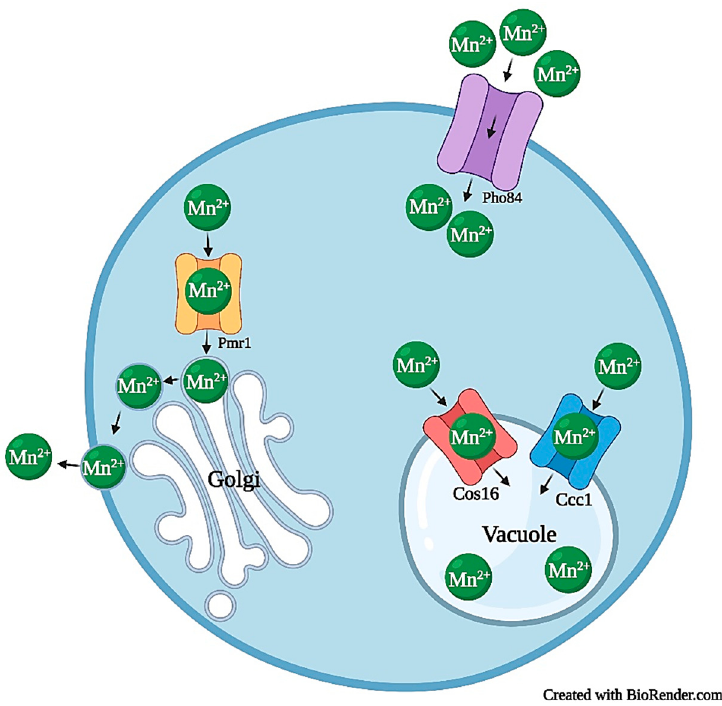
Figure 3. Mn 2+ uptake and detoxification systems in S. cerevisiae .